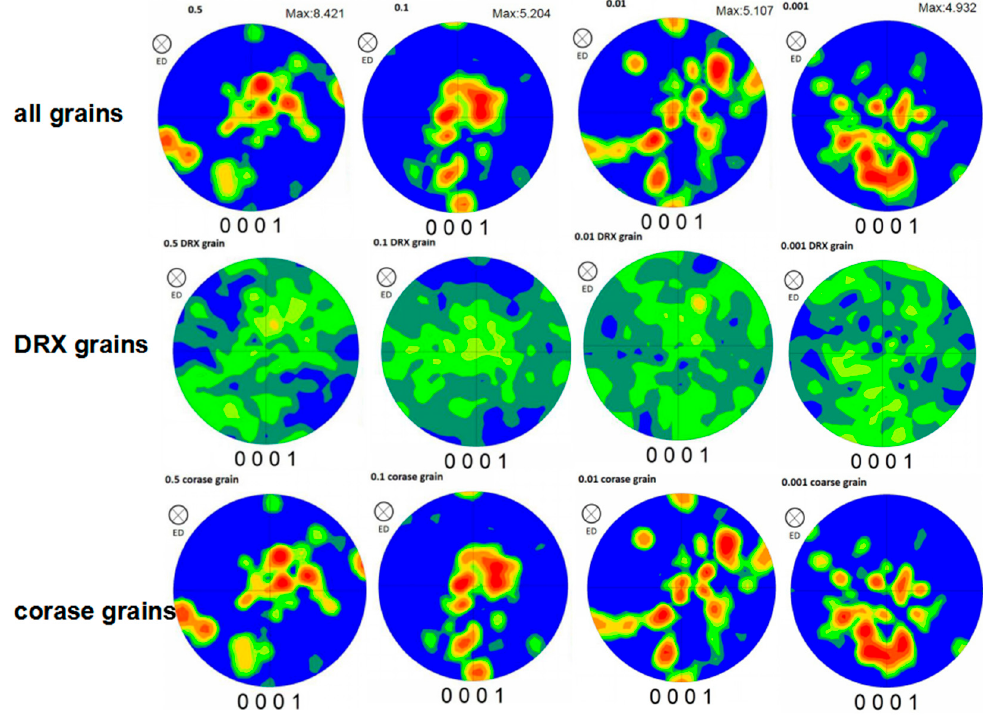
Figure 9. The (0001) pole figure of all the grains, DRXs, and coarse grains at different strain rates, respectively.